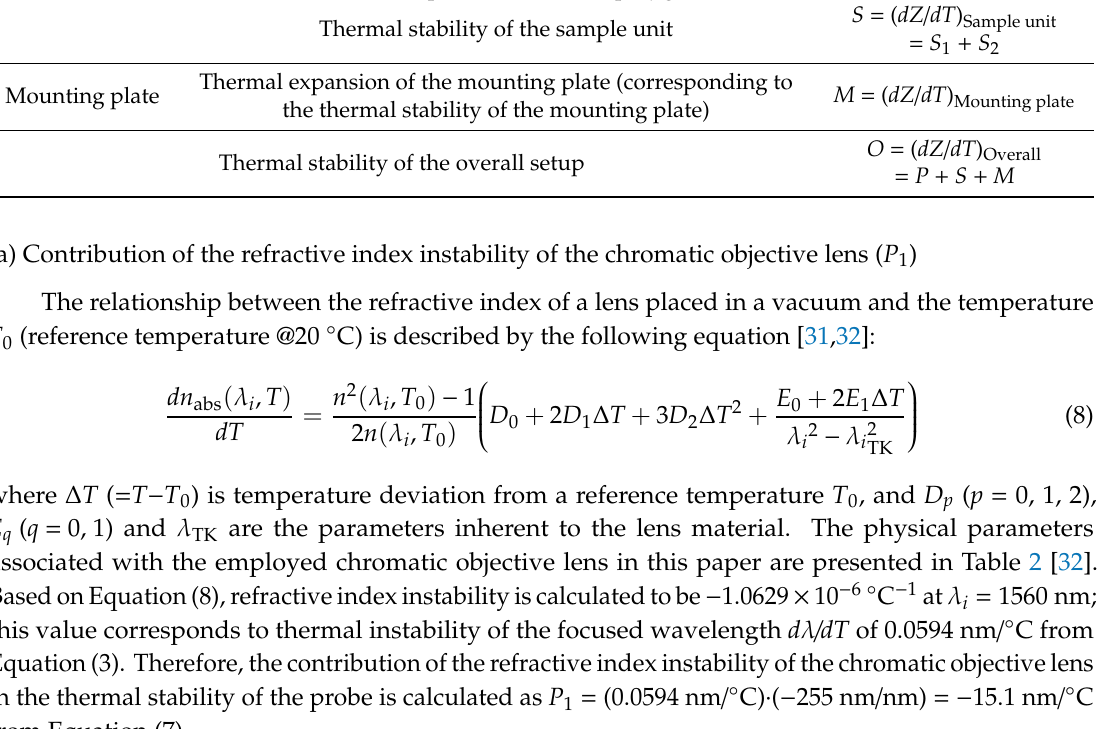
Table 1. Possible factors contributing to the thermal stability of the overall measurement setup. Item Factor Symbol Refractive index instability of the chromatic objective lens P 1 = ( dZ / dT ) P1 Refractive index instability of the surrounding air P 2 = ( dZ / dT ) P2 Thermal expansion of mechanical jigs P 3 = ( dZ / dT ) P3 Probe Thermal expansion of optical path length Thermal stability of the probe Thermal expansion of the sample Sample unit Thermal expansion of the sample jig Thermal stability of the sample unit Thermal expansion of the mounting plate (corresponding to Mounting plate the thermal stability of the mounting plate) Thermal stability of the overall